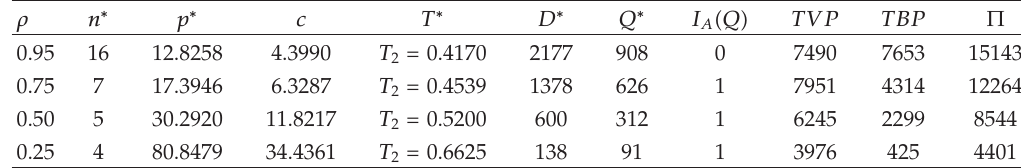
Table 3: Influence of optimal solution with di ff erent ρ values.